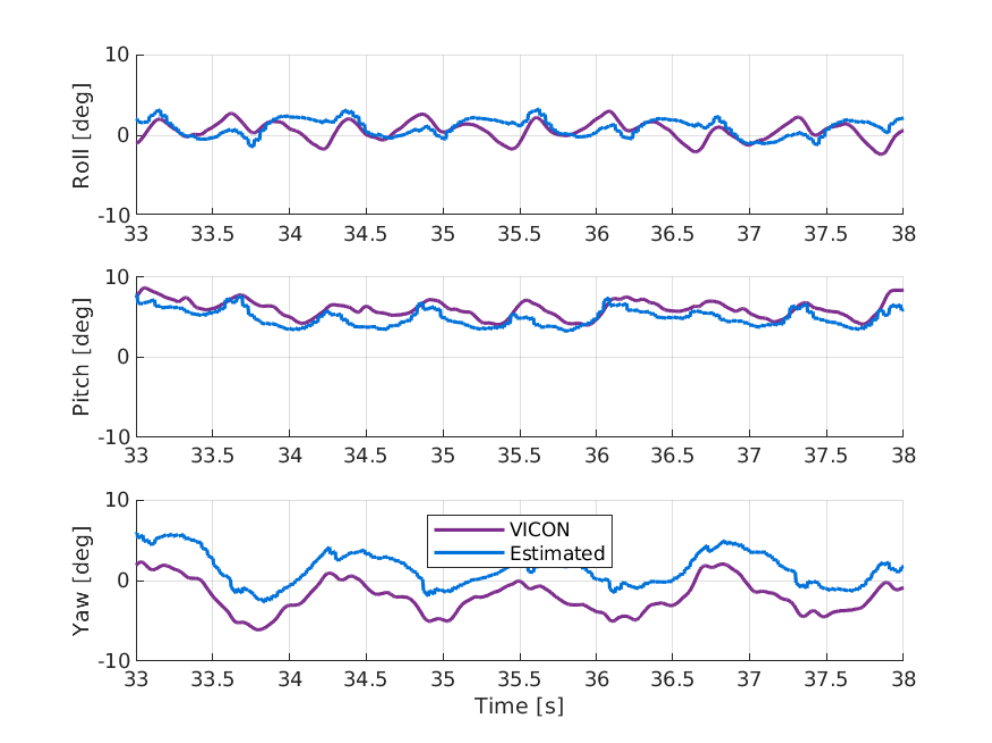
Figure 10. Comparison of roll, pitch, and yaw angles on pelvis segment during walking.